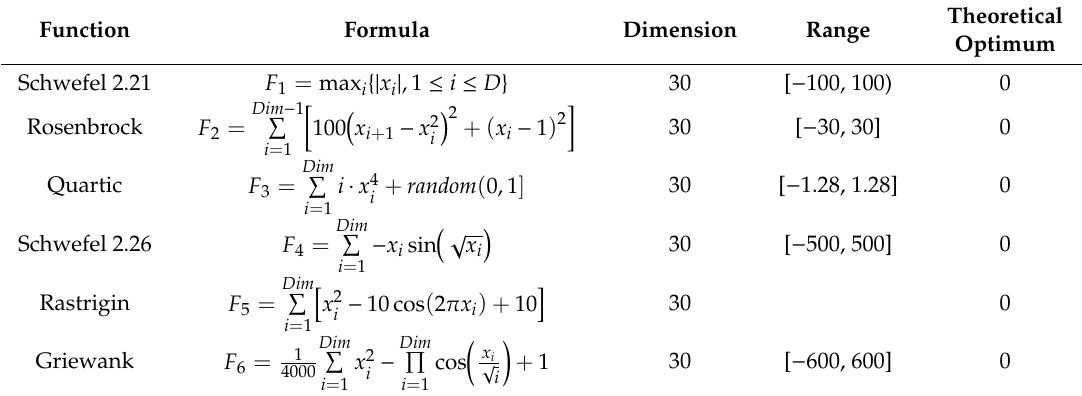
Table 10. The benchmark functions.